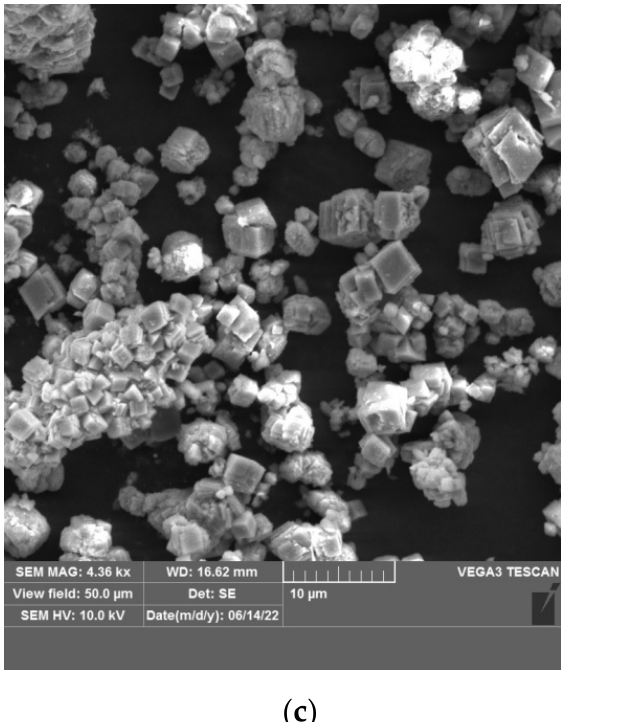
Table 5. Chemical composition of the leaching reaction products of washed phosphogypsum. No.